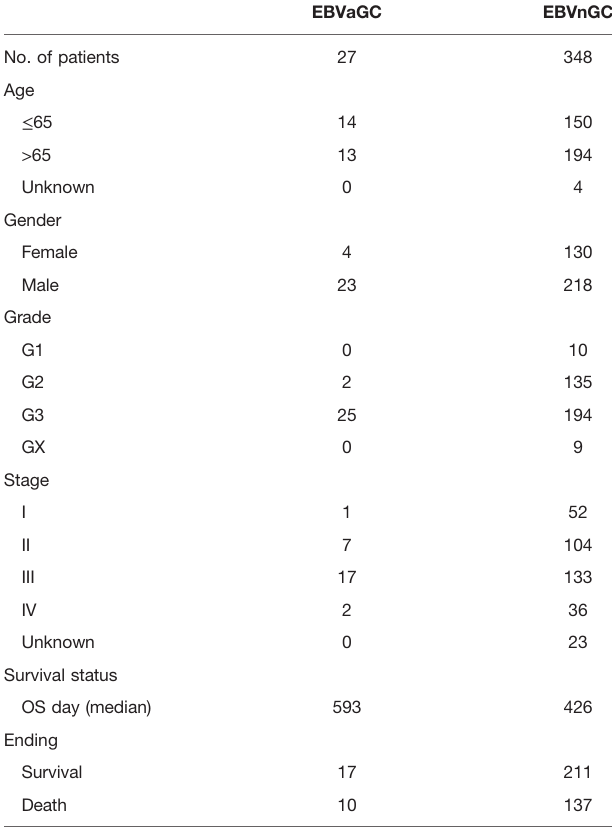
TABLE 1 | Clinical characteristics of EBVaGC and EBVnGC patients in TCGA.